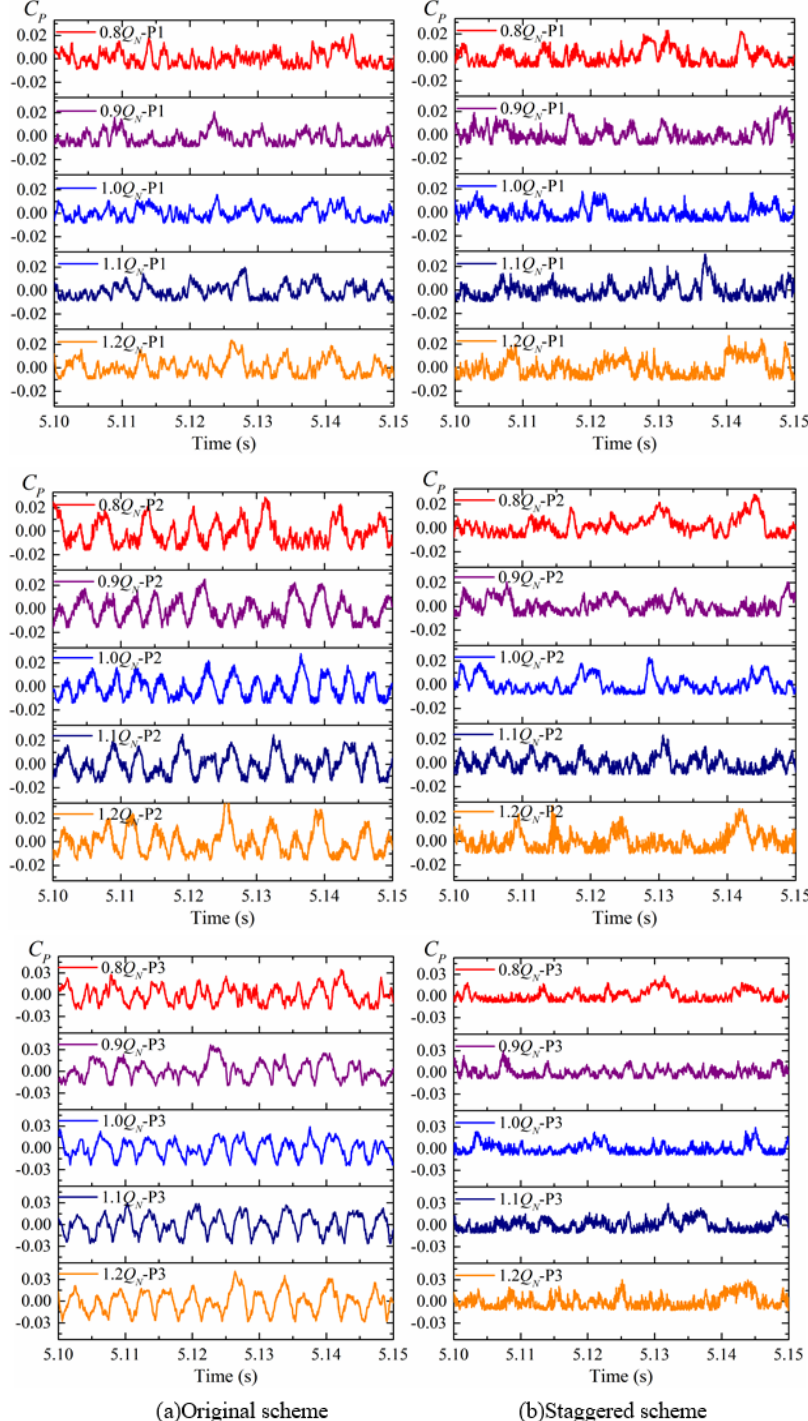
Figure 5. Time domain comparison of measured values of different